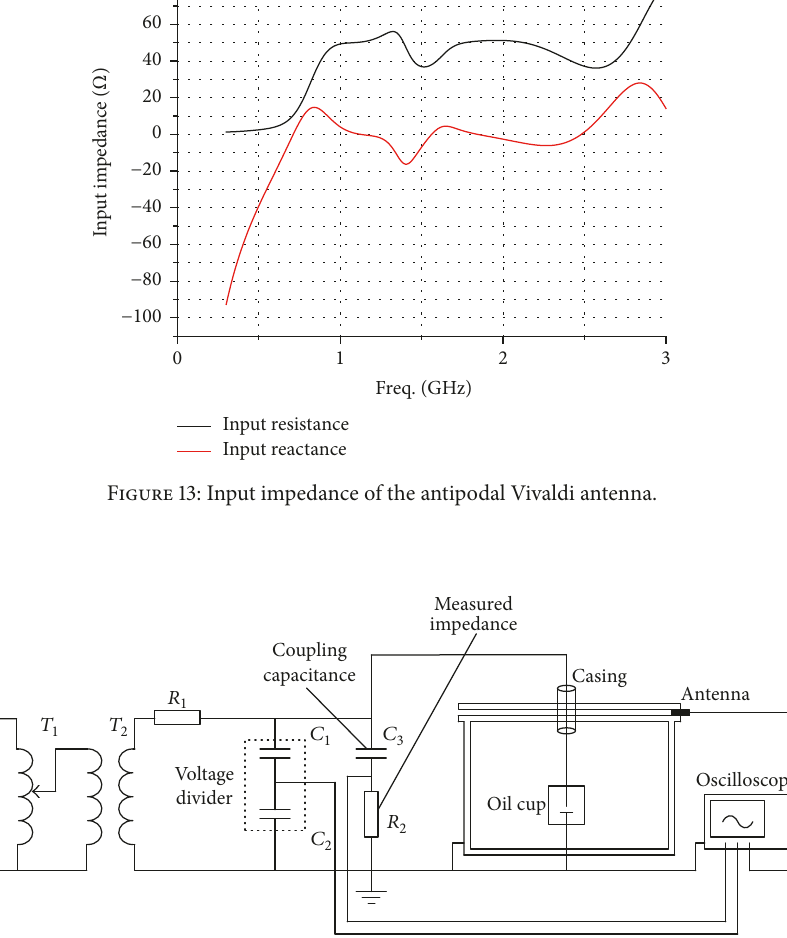
Figure 14: Experimental circuit